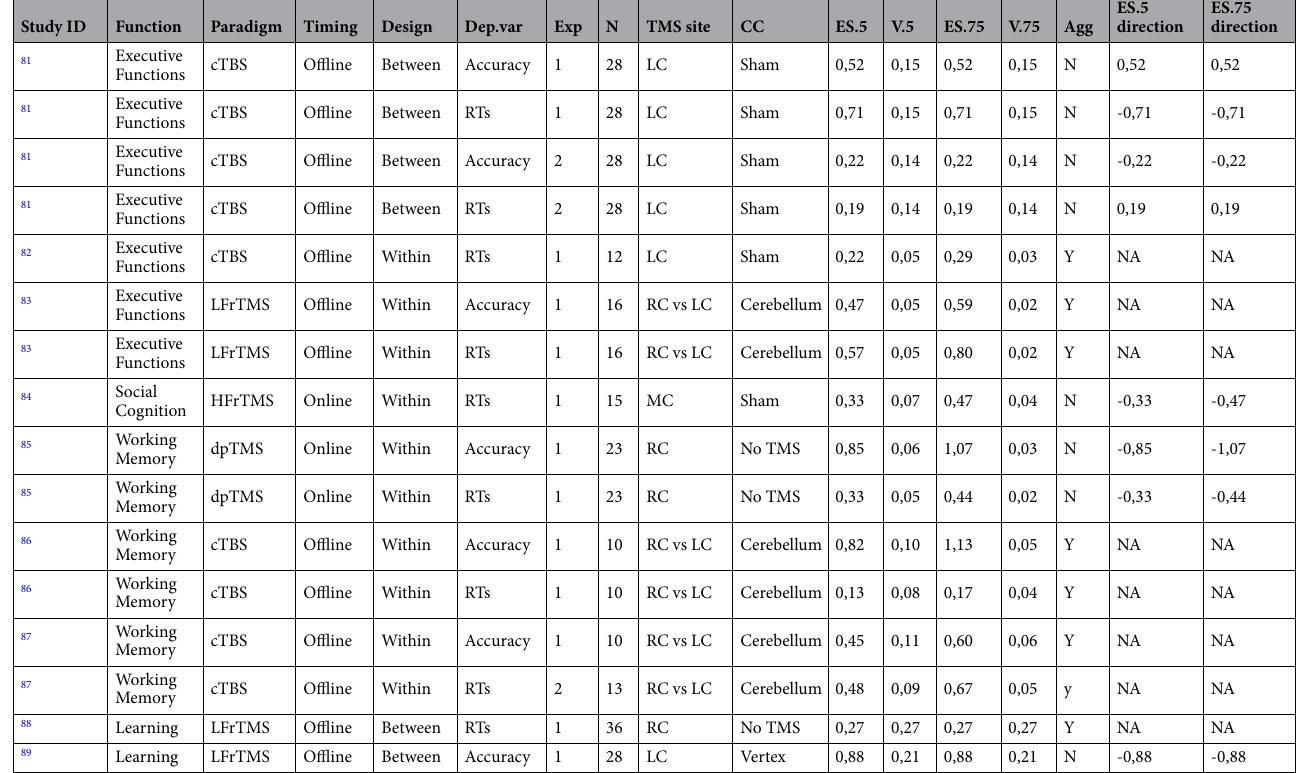
Table 1. The studies included in this meta-analysis. TBS theta-burst stimulation, LFrTMS low-frequency repetitive TMS, tpTMS triple-pulse TMS, spTMS single-pulse TMS, HFrTMS high-frequency repetitive